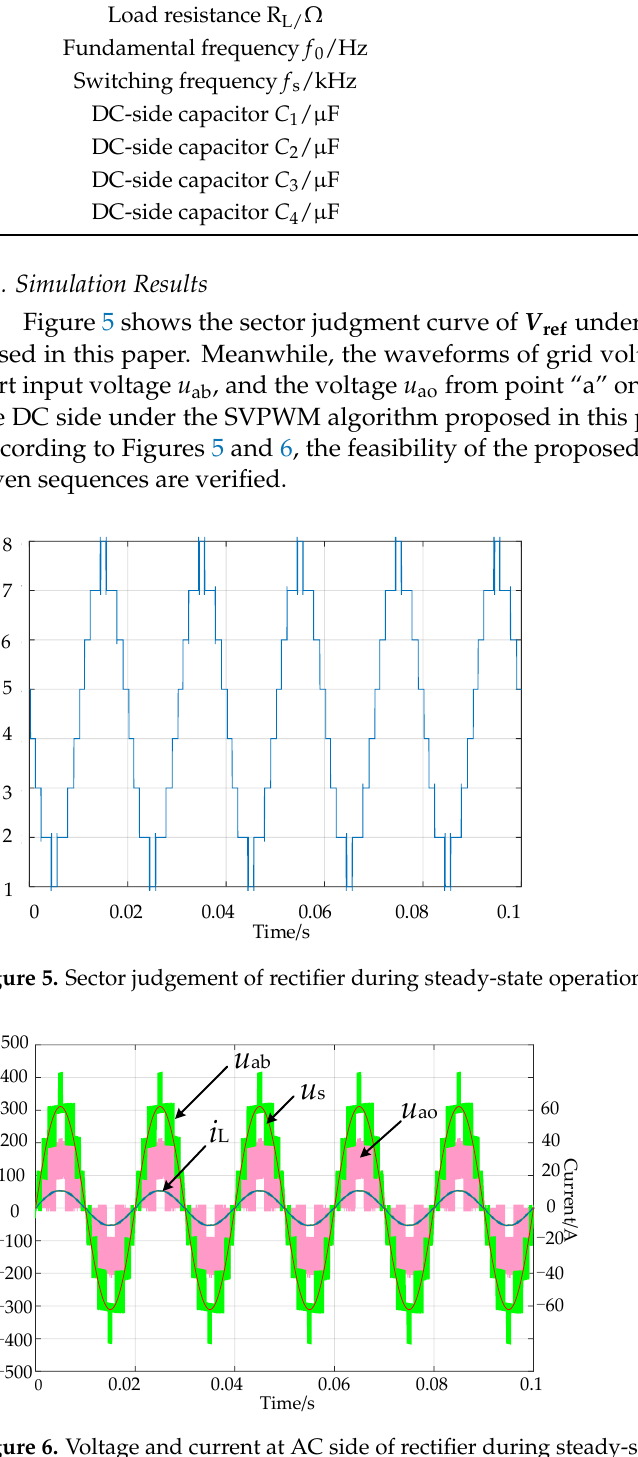
Figure 6. Voltage and current at AC side of rectifier during steady - state operation.